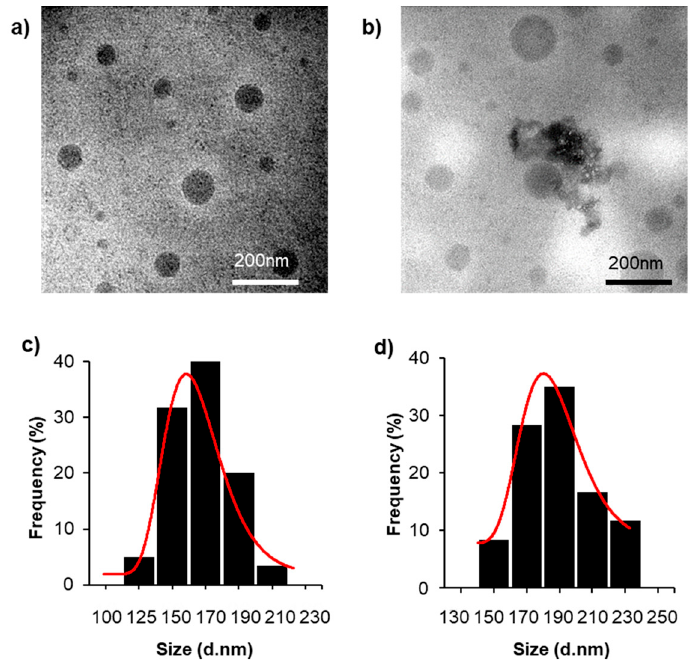
Figure 2. Transmission electron microscope image and particle size distribution of ( a , c ) LP and ( b , d ) PTX-ANA-LP.